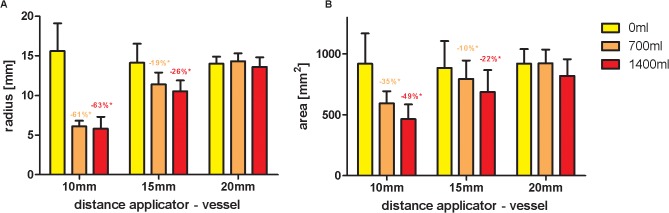
Minimum radius (A) and lesion area (B) of the ablation zone depending on applicator—vessel distance and vessel perfusion.In ablation procedures with vessels perfused with 700 ml/min located at 10 and 15mm distance, minimum radius of the resulting ablation zone was reduced by 61% and 19%, as compared to ablations with non-perfused vessels. Analogue, lesion area was reduced by 35% and 10%, respectively.